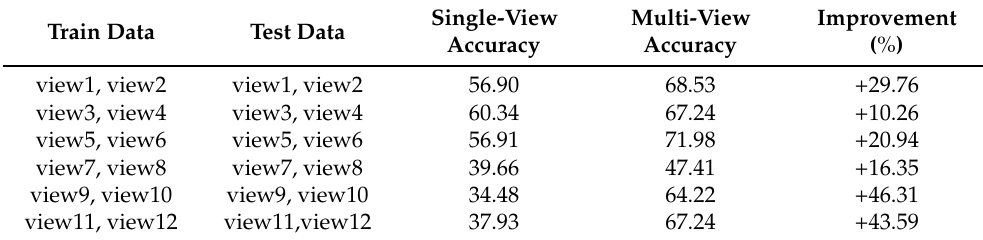
Table 4. Model accuracy of single-view and multi-view learning on KTH-TIPS2. Train Data